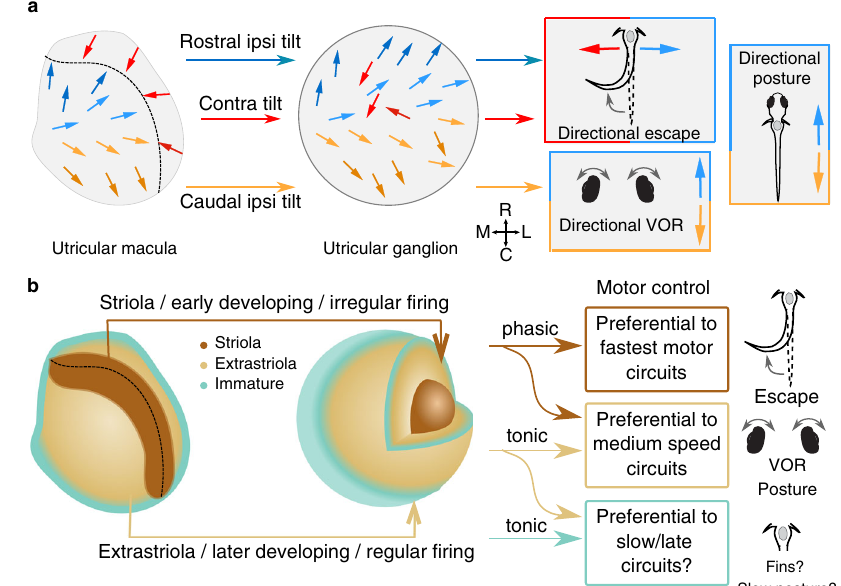
Fig. 7 | Directional tuning and developmental sequence are organizing prin- ciples of vestibulomotor connectivity. a Summary schematic of organization by directional tuning. Hair cells in the utricular macula, left, project via afferents that maintain rostrocaudal organization but not mediolateral organization. The utri- cular afferent ganglion is organized rostrocaudally, but contralateral tilt sensitive afferents are intermingled. These afferents project with different patterns to dis- tinct brainstem targets, conferring directional sensitivity in the mediolateral (escape) or rostrocaudal (VOR, posture) pathways. Colors indicate directional tuning as previously. b Summary schematic of organization by temporal